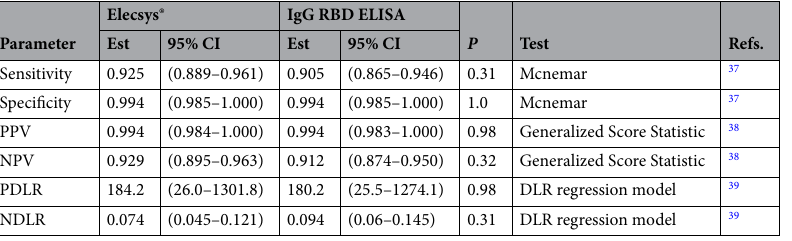
Table 1. Comparative diagnostic performance of Elecsys® and IgG RBD ELISA at ≥ 3 weeks